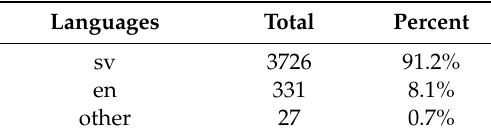
Table A53. Primary languages (se).